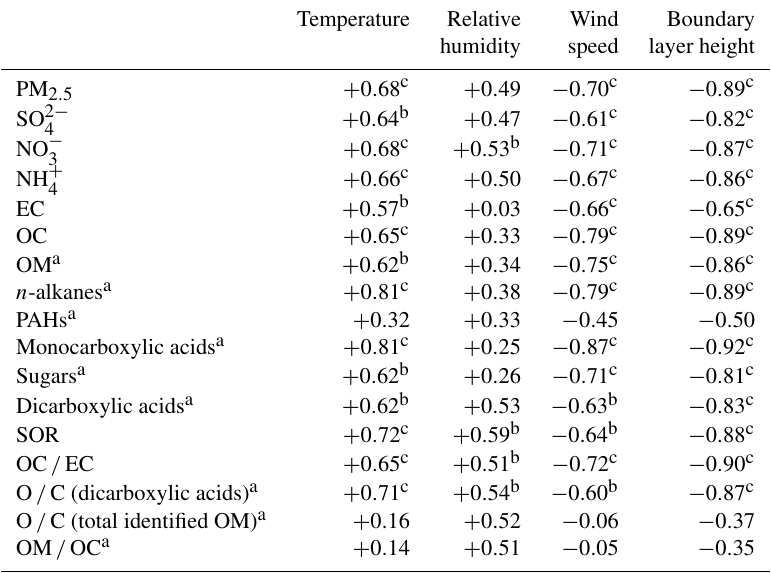
Table 5. Correlation coefficients between meteorological variables and each component in Seoul for the measurement period of 23 February to 9 March